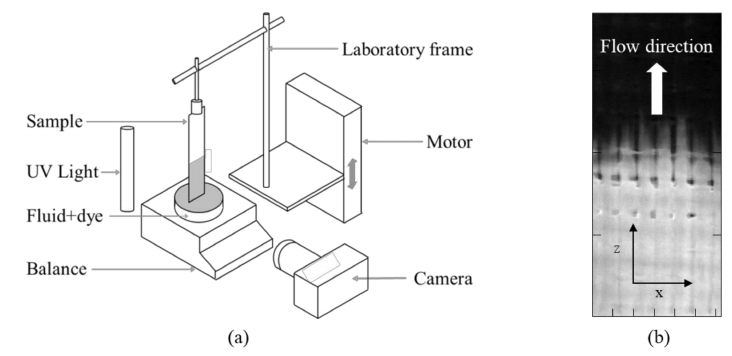
Figure 3. ( a ) Experimental setup for capillary rise measurements; ( b ) example of captured